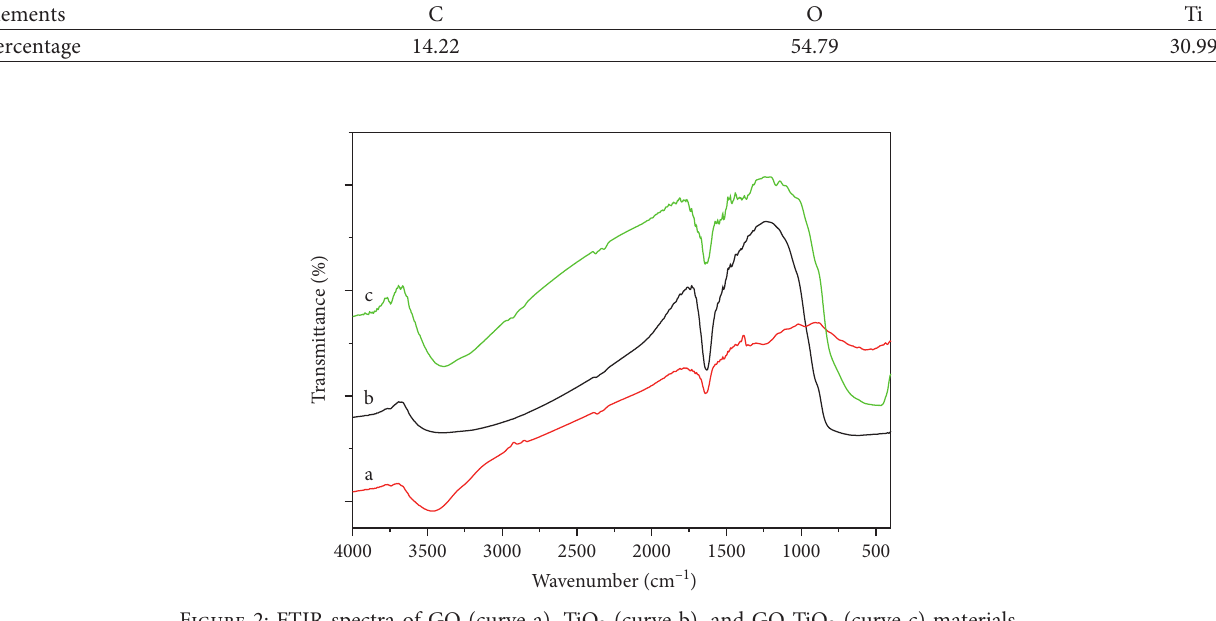
Figure 2: FTIR spectra of GO (curve a), TiO 2 (curve b), and GO-TiO 2 (curve c) materials.